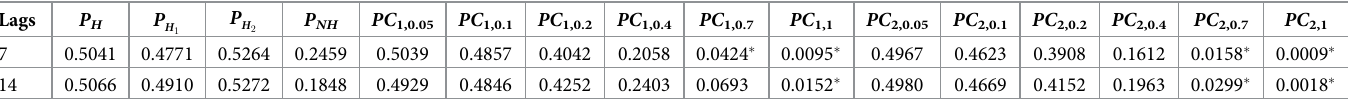
Table 7. Medians of 500 p-values of Ljung-Box test applied to the events of the simulated processes for different models (columns). Significant differences ( α = 0.05) are identified with an asterisk ( � ). Lags P H P H